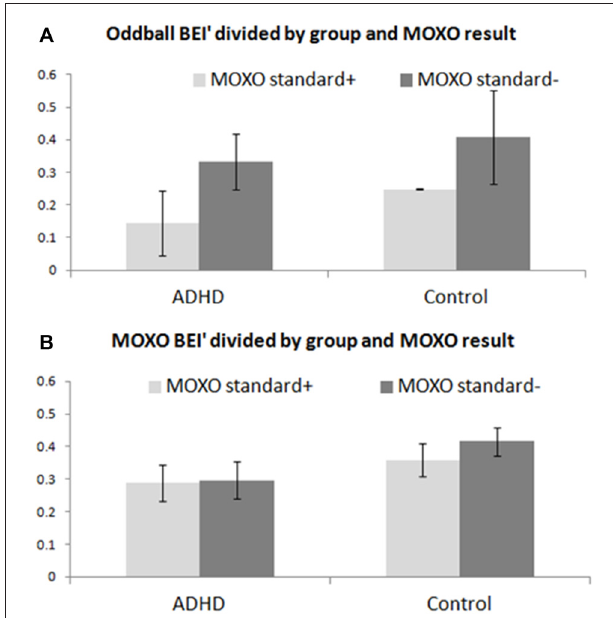
FIGURE 5 | Comparison of BEI’ between participants based on pre-treatment MOXO. BEI’ comparison between participants with standard+ pre-treatment MOXO functional results and those with standard − pre-treatment MOXO functional results, in both ADHD and control groups. (A) Mean ± standard deviation of BEI’ during the pre-treatment 1-min auditory oddball for standard+ and standard − participants. (B) Mean ± standard deviation of BEI’ during the pre-treatment MOXO test for standard+ and standard − participants.